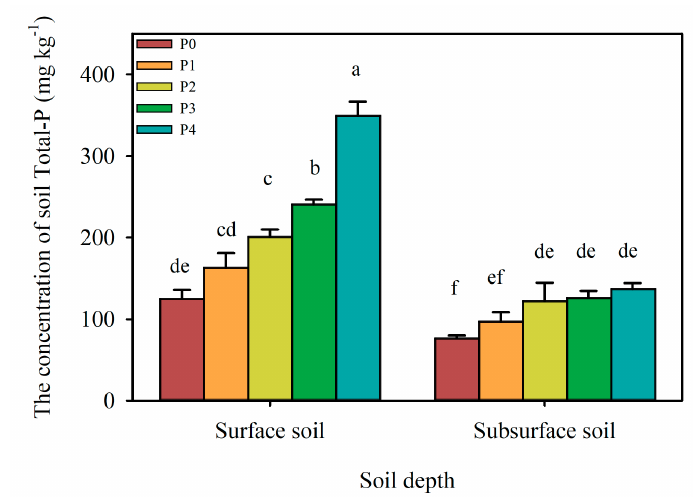
Figure 2. The concentration of soil total P under different P treatments come from field experiment. Note: Mean ± Standard deviations, different letters above column indicate significant difference ( p < 0.05) between various treatment in different soil depths.